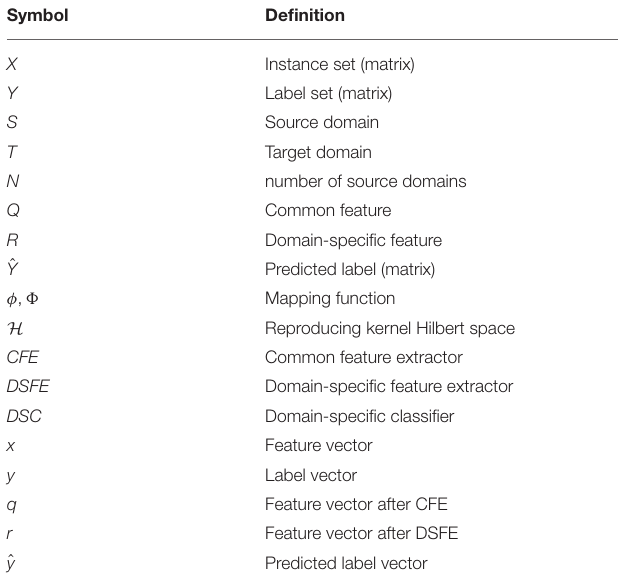
TABLE 1 | Notation